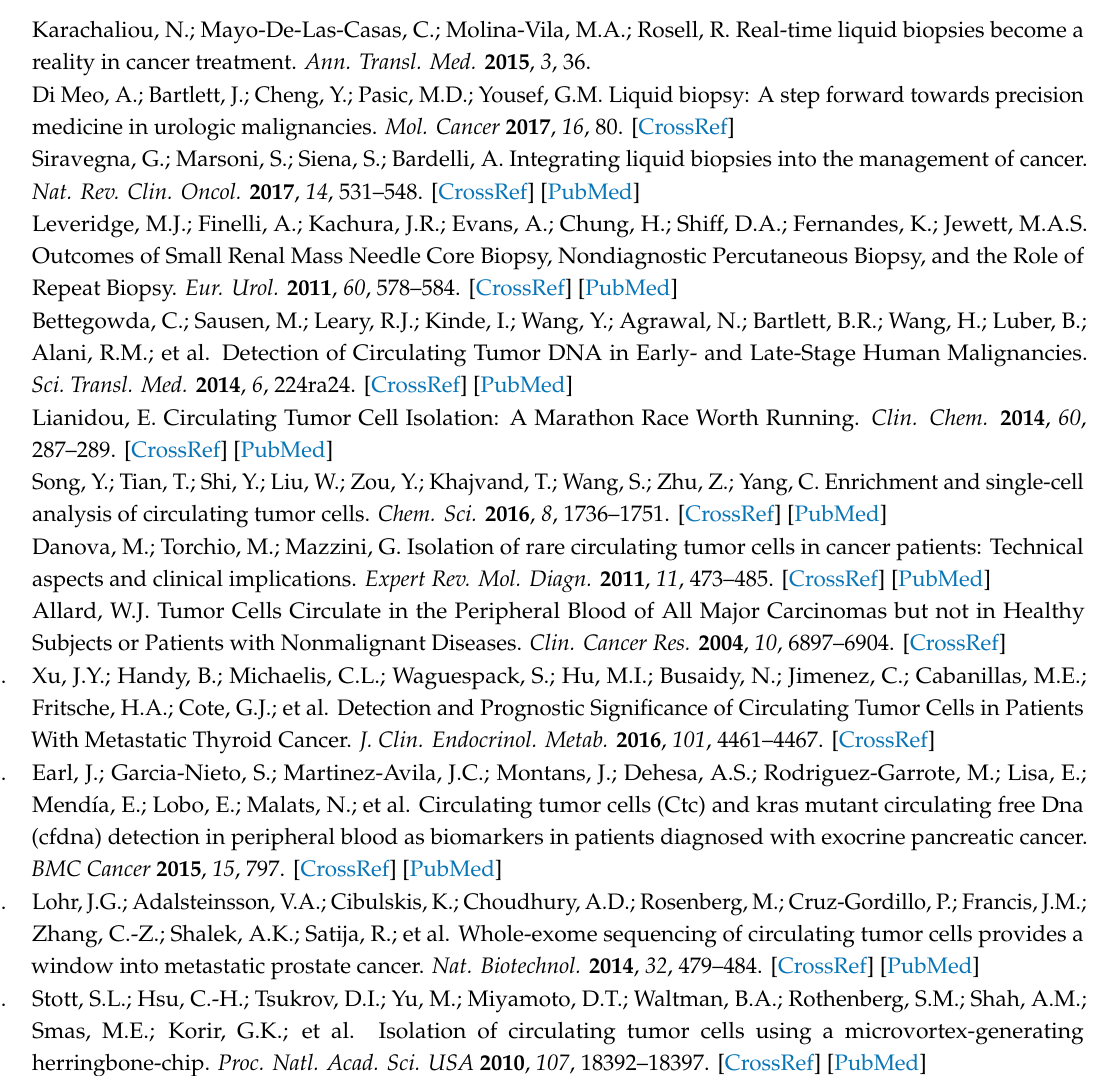
lines as analysed by flow cytometry Figure S3: Recovery rate and separation rate of MCF7 spiked to whole blood; Video S1: Separation of EpCAM-positive CTCs from whole blood of NSCLC patients; Video S2: Separation of EpCAM-positive MCF7 cells spiked into whole blood of healthy